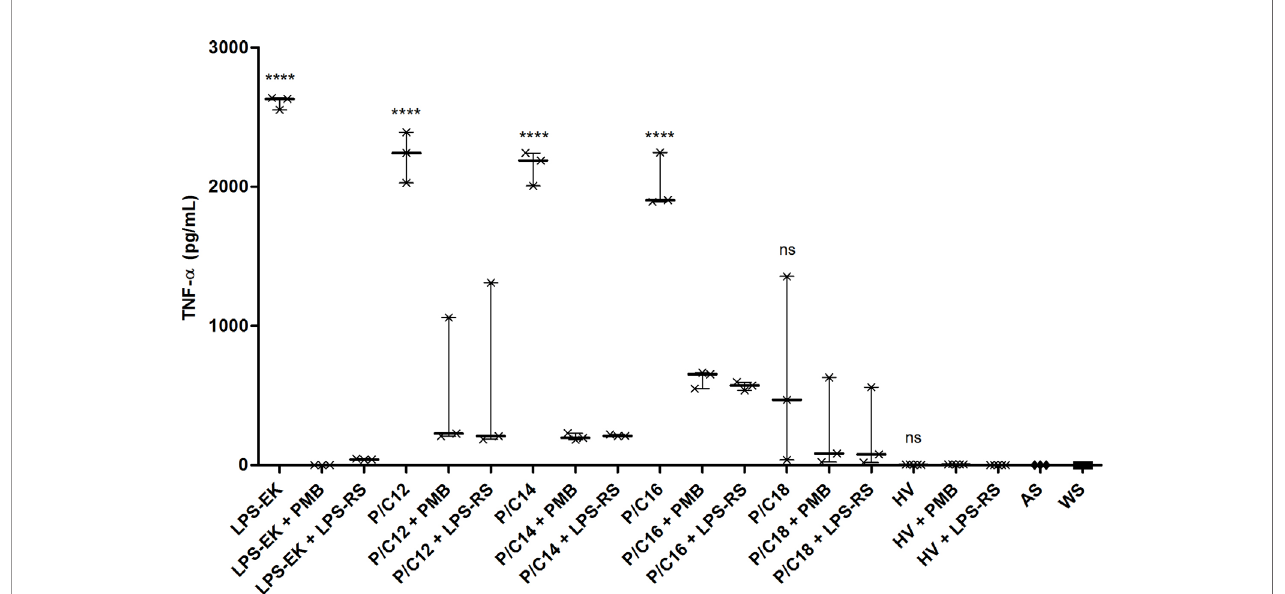
FIGURE 6 | TLR4-dependent in fl ammation pathway in end-stage renal disease (ESRD) patients and healthy volunteers (HV). Human monocytes were stimulated with ESRD patient ’ s serum according to the highest proportion of each LPS subtypes (P/C12, P/C14, P/C16, P/C18, n = 3 for each), with HV serum (n = 5), or with decomplemented autologous serum and LPS from E. coli (LPS-EK, 10ng/mL, n = 3) for the positive control. Moreover, cells and sera were cultured with an antagonist of TLR4 (LPS from R. sphaeroides , LPS-RS, 100 ng/mL) or an antibiotic blocking LPS activity (Polymyxin B, PMB, 100 µg/mL). After 12 hours of stimulation, supernatants were collected and the secretion of cytokines TNF- a was measured by enzyme-linked immunosorbent assay (ELISA). Bars and errors bars are expressed as median with interquartile range. Mann-Whitney U test of single stimulation (LPS-EK or sera) and co-stimulation with PMB or LPS-RS values, **** p < 0.0001, ns, not signi fi cant; LPS, lipopolysaccharide; TLR4, Toll-like receptor-4; TNF, tumor necrosis